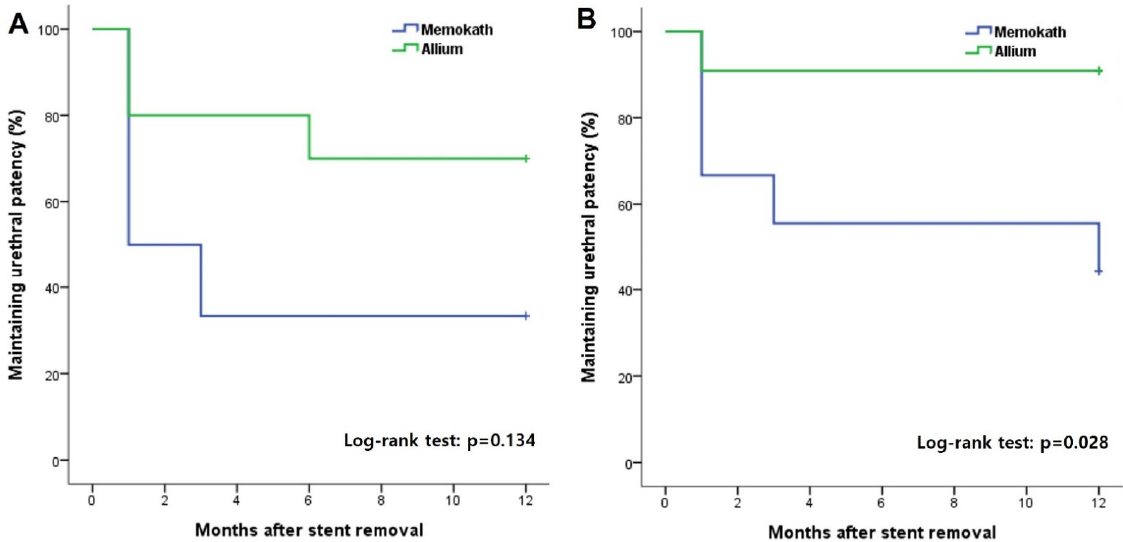
Figure 4. Kaplan–Meier curves showing the maintaining urethral patency rate with Memokath and Allium stents in groups subdivided into patients with direct visual internal urethrotomy with ( B ) or without ( A ) transurethral endoscopic removal of urethral scar tissue.